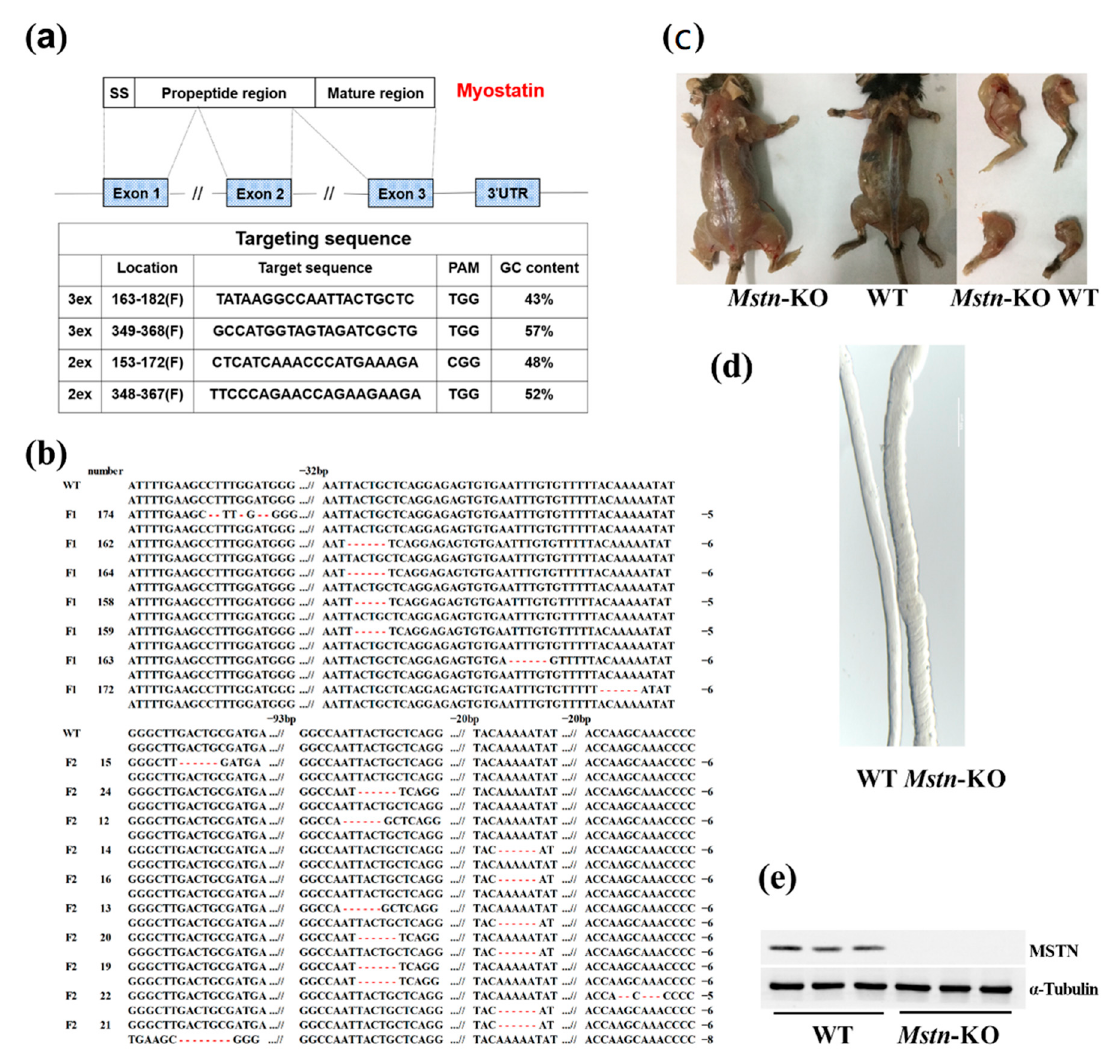
Figure 1. Production of myostatin knockout ( Mstn -KO) mice mediated by CRISPR/Cas9 techniques. ( a ) gRNA sequence of the MSTN gene for CRISPR/Cas9. ( b ) Mutant Mstn genotypes of derived progenies, red indicates a missing base. ( c ) Representative images of muscles of Mstn -KO and WT mice. ( d ) Images of teased single muscle fibers for muscle fibers in Mstn -KO and WT mice. ( e ) Expression of MSTN protein in Mstn -KO and WT mice ( n = 3).